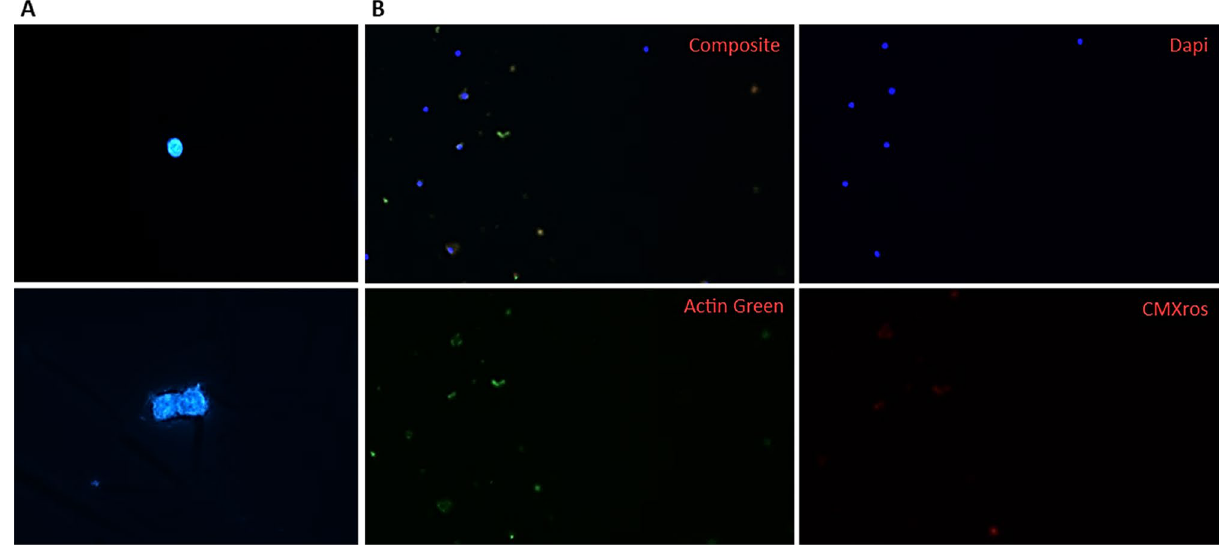
Figure 1. Examination of nuclei morphology by fluorescent staining. ( A ) Representative images of DAPI- stained nuclei showing successful isolation of a healthy single nucleus (top) and nuclei aggregation (bottom). Nuclei doublet also shows abnormal nuclear morphology. ( B ) Positive fluorescence staining with DAPI, CMXros, and Actin Green (clockwise). The composite image (top left) confirms live cell staining after enriching for nuclei using the